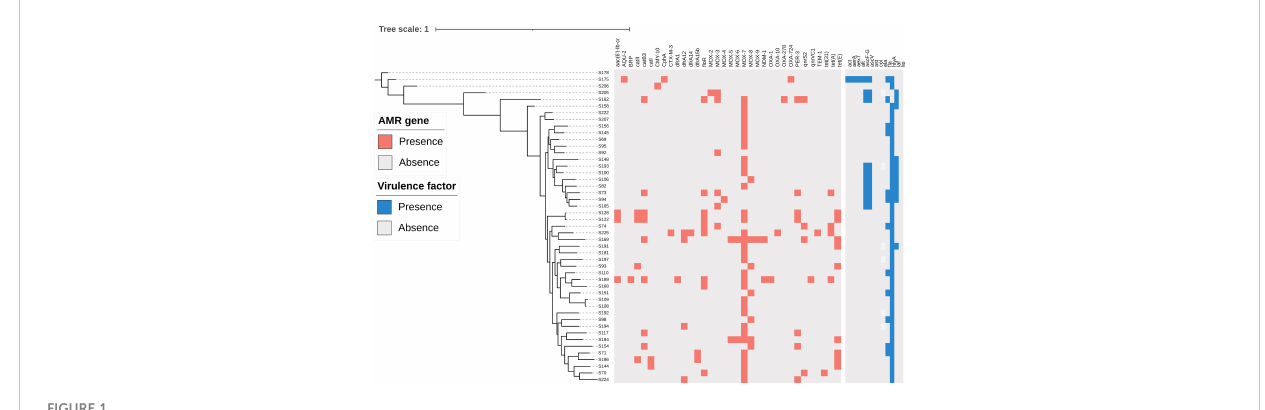
FIGURE 1 Construction of phylogenetic tree of 47 A . caviae strains. Antimicrobial resistance (AMR) genes were detected with more than 70% coverage and 80% identity in each genome using BLAST. Virulence genes were identi fi ed by blasting the VFDB database. Red and blue represented the antimicrobial resistance genes and virulence genes, respectively.